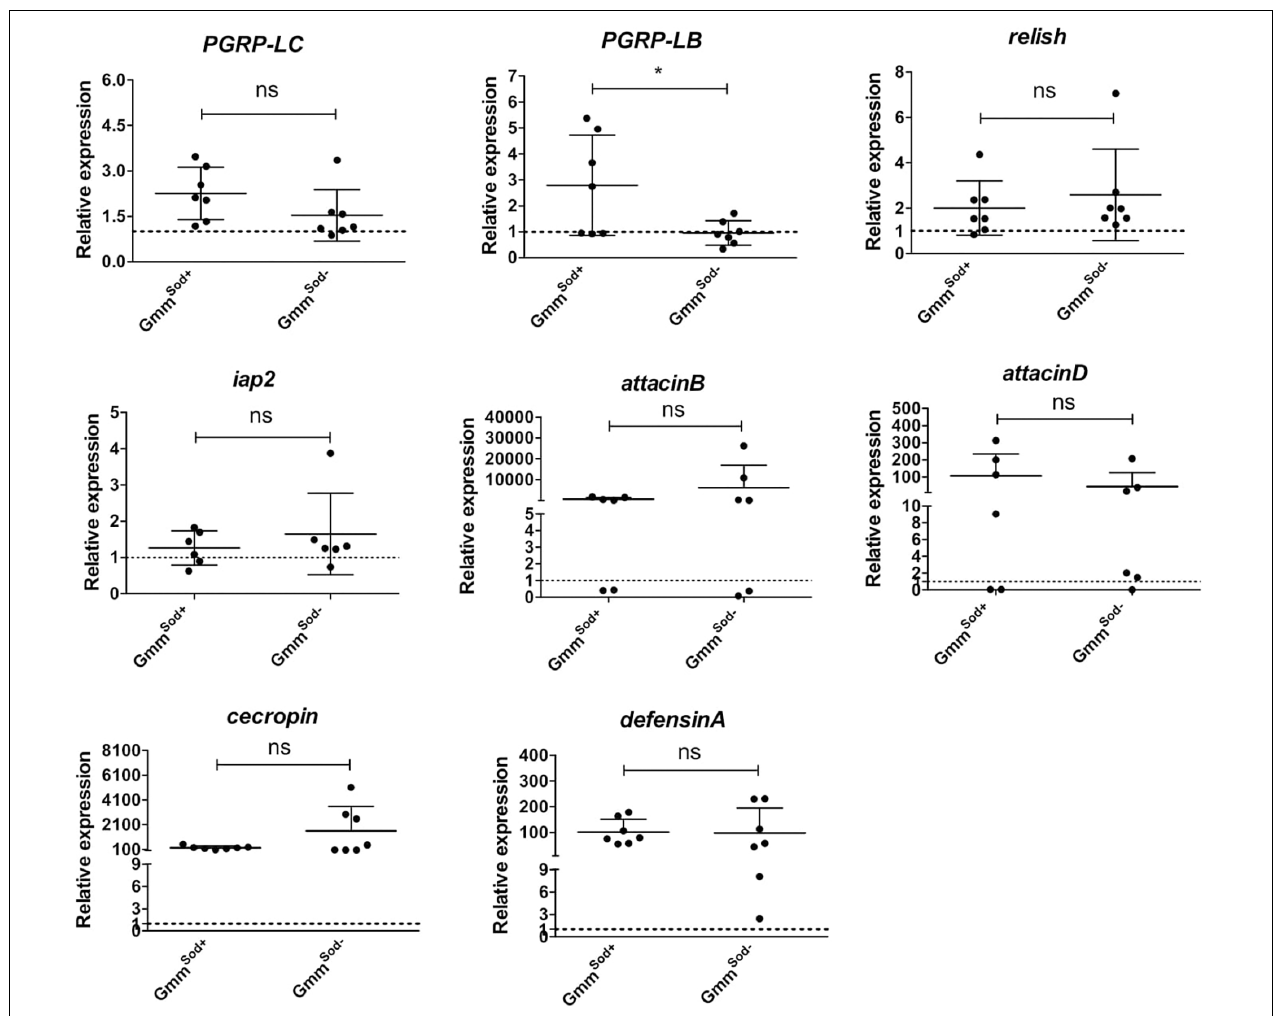
FIGURE 7 | Relative expression levels of innate immunity-related genes in the abdomen of symbiotic ( Gmm Sod + ) and S. glossinidius -free ( Gmm Sod − ) flies exposed to 10 5 CFU E. coli. Bacterial exposure was performed on day 8 post-eclosion via intrathoracic microinjection as well as per os and total RNA was extracted after 48 h. The expression levels were obtained by qRT-PCR analysis and normalized against the two tsetse reference genes β -tubulin (GMOY000148) and pleiotrophic regulator 1 (GMOY006161). Expression in each abdomen is plotted relative to the mean of the injection-control groups in Gmm Sod + and Gmm Sod − flies resp. Values are represented as the mean with the standard deviation. N = 7 independent replicates per group. ∗ p -value < 0.05; iap2, inhibitor of apoptosis 2; ns, not significant; PGRP, peptidoglycan recognition